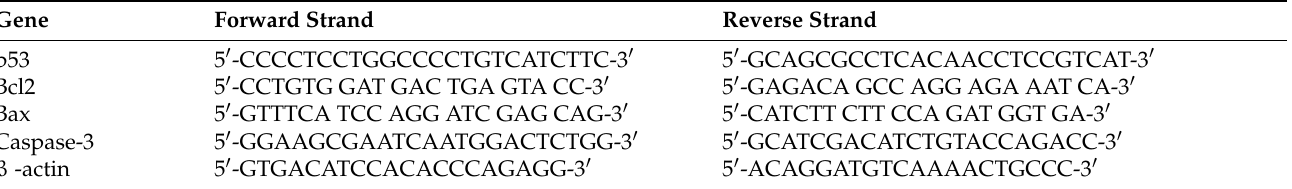
Table 2. Primer Sequence of different